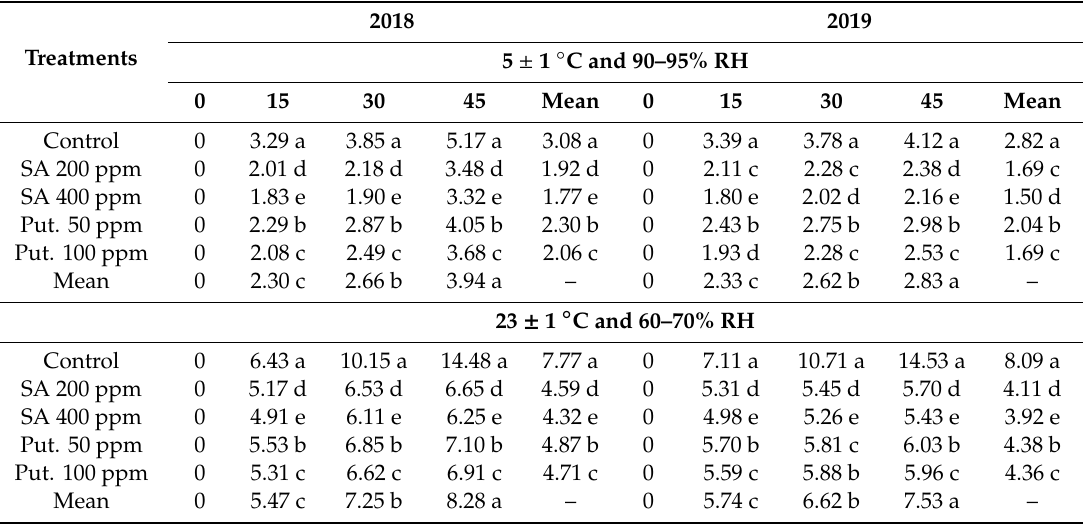
Table 1. E ff ect of salicylic acid (SA) and putrescine (Put) on weight loss (%) of Murcott mandarin fruit at 15, 30, and 45 days of storage during 2018 and 2019